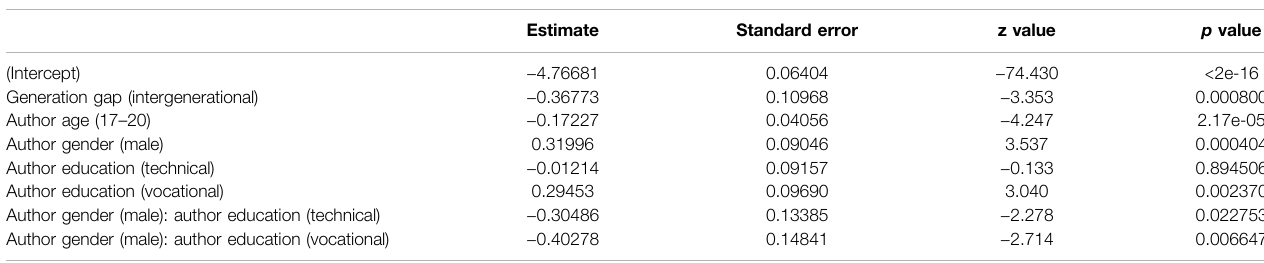
TABLE 7 | Brevity: Fixed effects 12 .